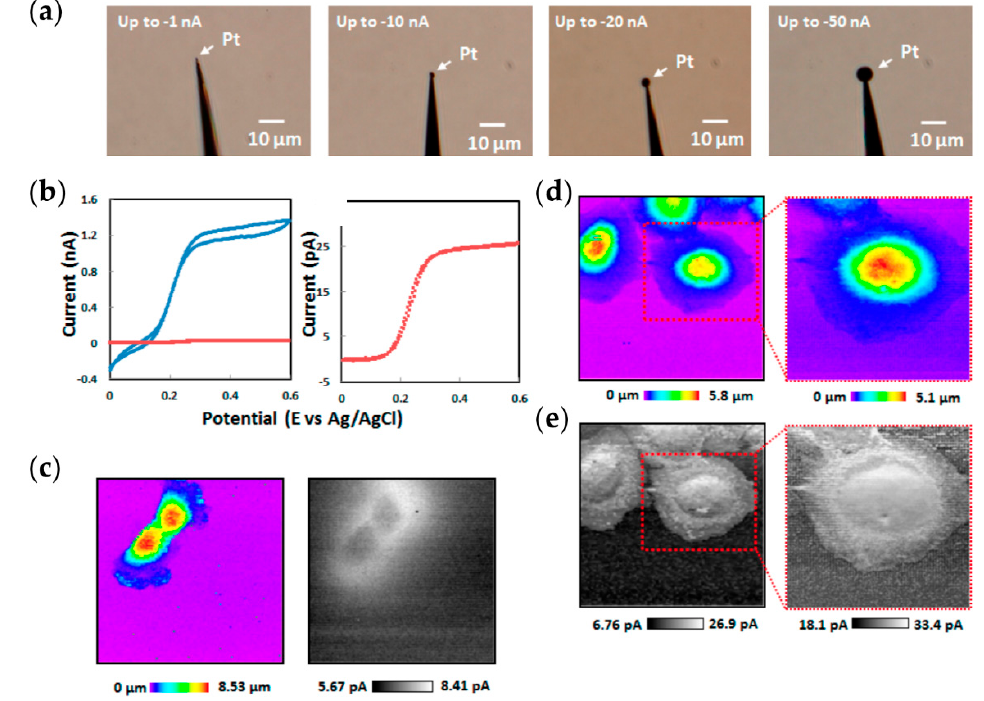
Figure 5. Dual barrel SECM-SICM probes are used to image immunocytochemically-stained EGFR proteins on A431 cells. ( a ) SECM-SICM probes with Pt sphere electrodeposited on the carbon SECM nanoelectrode, with increasing (left–right) amount of Pt deposition. ( b ) Cyclic voltammogram of a bare carbon nanoelectrode (red) and a Pt-deposited probe (blue) at − 10 nA final deposition. ( c ) Topographic (left) and electrochemical (right) image of A431 cells acquired using a bare carbon electrode over an 80 × 80 µm scan area. ( d ) Topography and ( e ) electrochemical images of a A431 cells acquired using a Pt-deposited electrode, where the scan area is 75 × 75 µm on the left and 50 × 50 µm on the zoom-in (right). (Adapted with permission from Reference [75]. Copyright (2015) American Chemical Society).